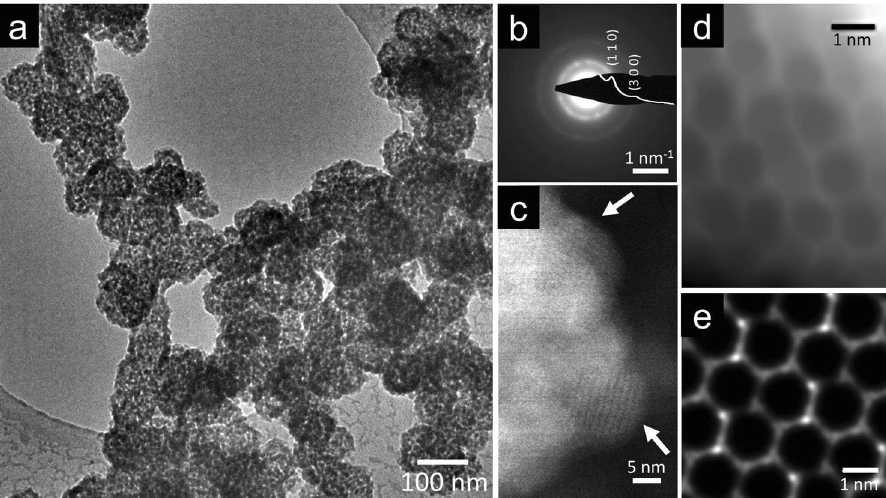
Figure 2. ( a ) BF TEM image of agglomerated Co-MOF-74 nanocrystals. ( b ) SAED pattern of such nanocrystals in which the extracted radial intensity profile in the overlay confirms their Co-MOF-74 structure 18 . ( c ) ADF STEM image of a nanocrystal agglomerate such as in ( a ) at higher magnification. The observed lattice fringes within the individual nanocrystals (marked by arrows) are consistent with Co-MOF-74. ( d ) ADF STEM image (Gaussian blurred and minimum filtered) consistent with the pore structure of a Co-MOF-74 nanocrystal as in ( c ). ( e ) STEM image simulation of a Co-MOF-74 crystal viewed along the [001] zone axis (rotated by − 18° in plane to match ( d ). Further details on TEM/STEM results are given in SI, section